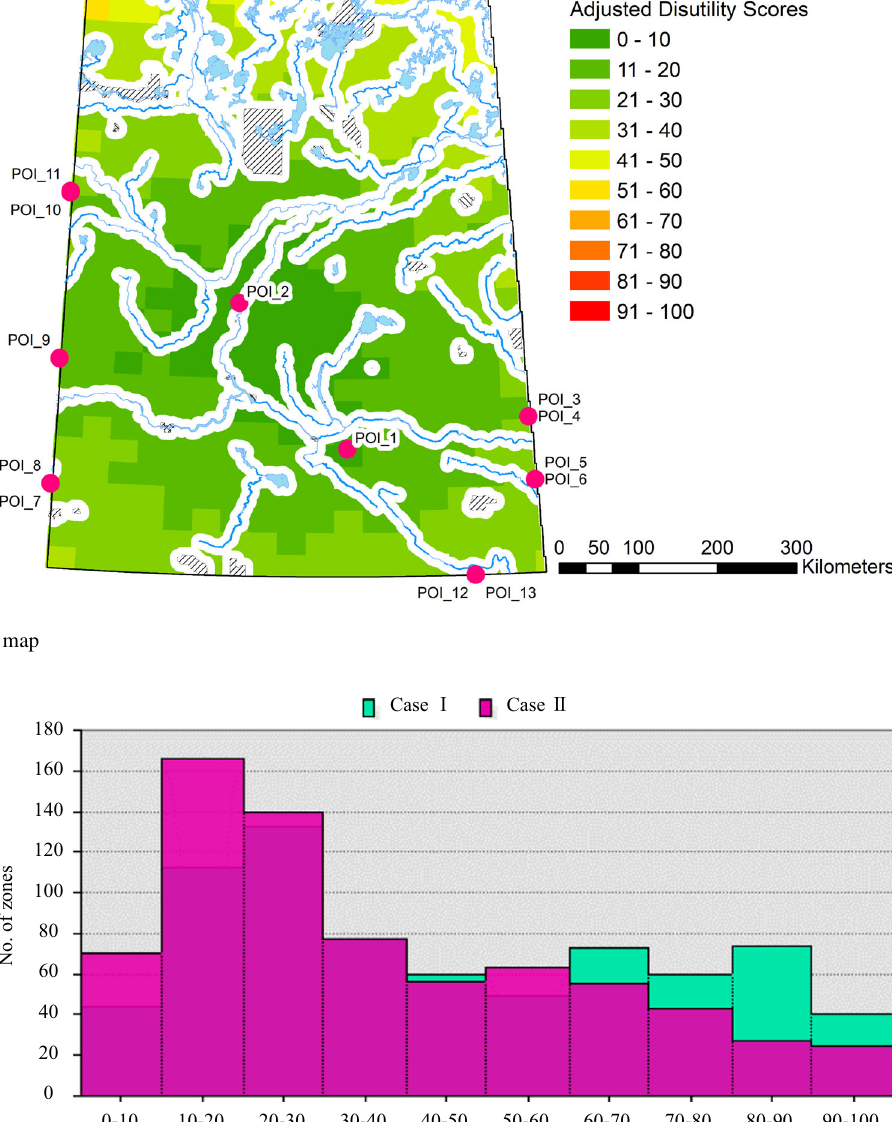
Fig. 8 Comparison of Case I and II